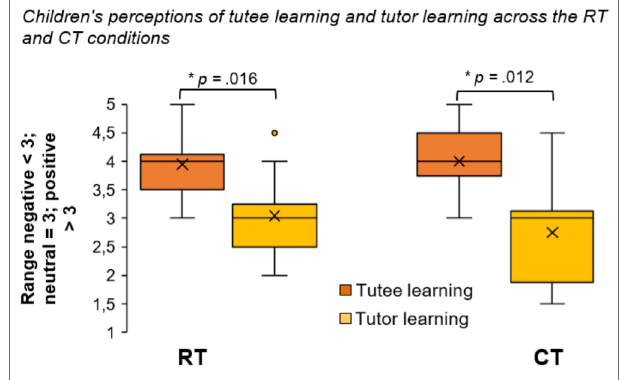
FIGURE 6 | Box plot (from questionnaires) showing children ’ s perceptionsoftuteeandtutorlearninggainsinmathematicsacrossconditions (x = means; lines = medians; whiskers =